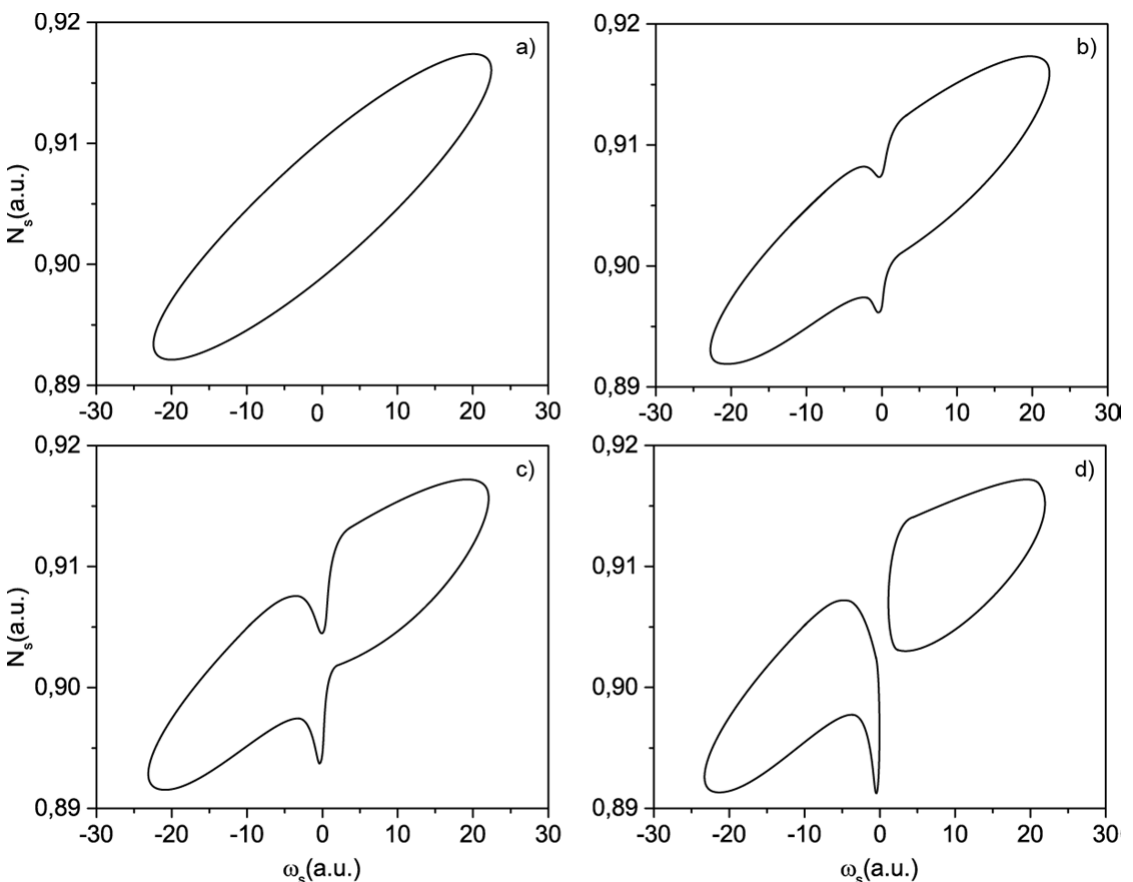
Figure 3. The location of external cavity modes for a fixed value of feedback strength of conventional optical feedback ( 